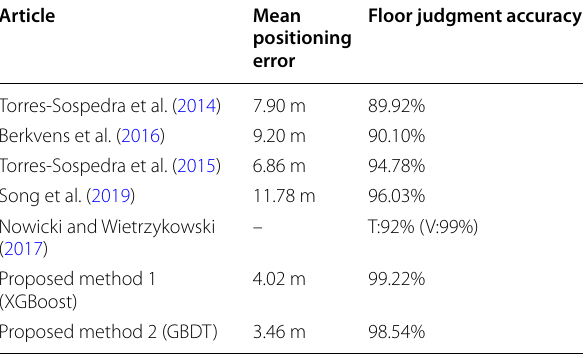
Table 4 The results of other articles and the method we proposed